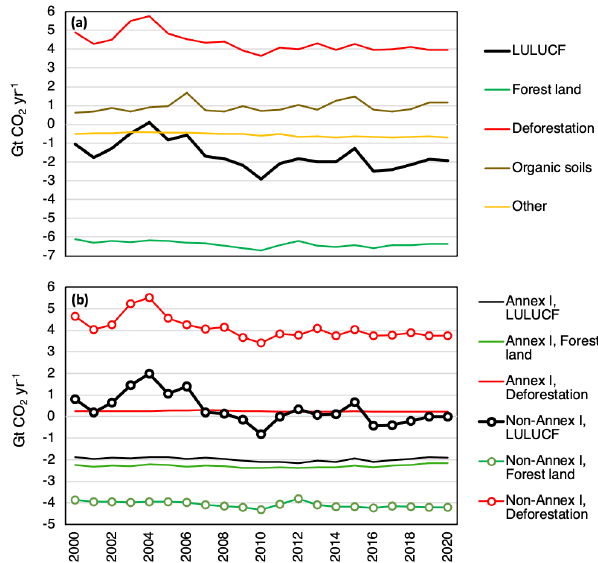
Figure 2. Global trend 2000–2020 of CO 2 fluxes from the NGHGI DB for the various land uses and land-use change categories (a) and for Annex I vs. non-Annex I countries (b) .